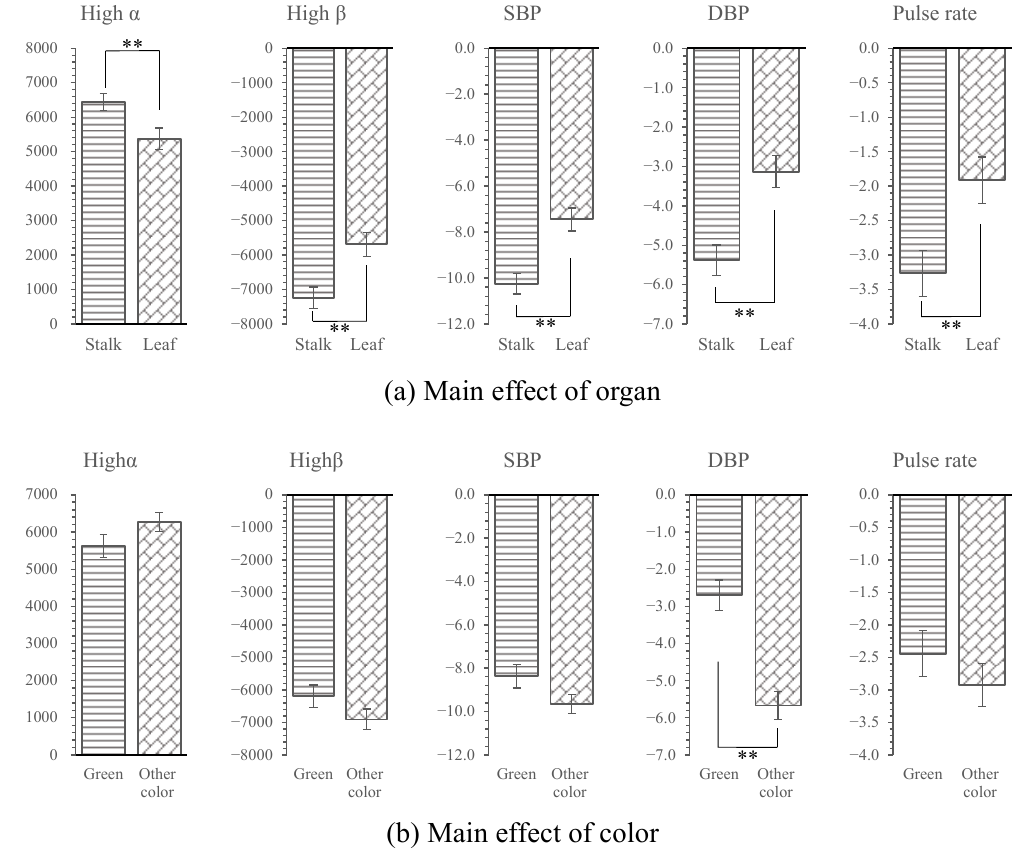
Figure 7. Mean effect of organ and color on physiological indicators. The zero point represents the value measured after participants viewing urban images. SBP: systolic blood pressure; DBP: diastolic blood pressure, n = 300; mean ± SE, ** p < 0.01.